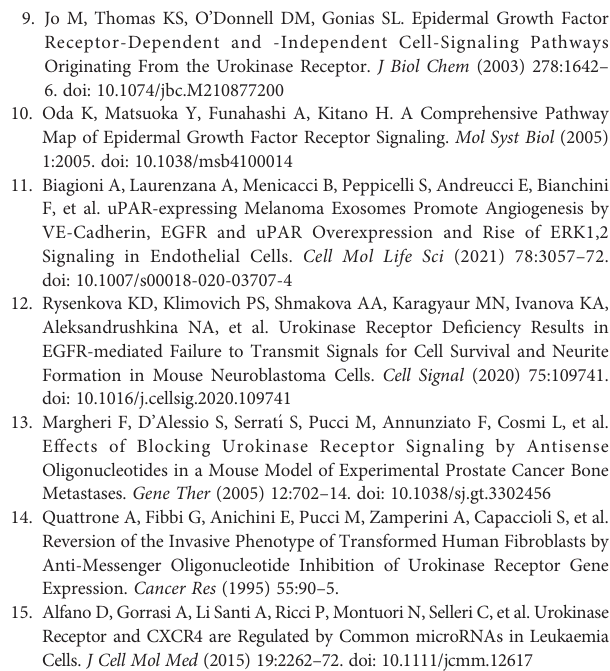
Supplementary Figure 1 | Annexin V/PI assay on control and uPAR KO cells. Values are mean ± SD; ns, not signi fi cant (n=3). (Student ’ s Test). Supplementary Figure 2 | Total RNA isolated was subjected to Reverse Transcriptase-PCR analysis of uPAR-3 ’ UTR expression, and b 2M was used as a loading control (n = 3). Supplementary Figure 3 | Cells were tested for EGFR expression by FACS analysis after anti-miR146a treatment for 24h (n=3). Values are mean ± SD; ***p < 0.0001 (Student ’ s Test). Supplementary Figure 4 | Cellular growth counting the total number of cells 24 and 48 h after the initiation of the culture. (n = 3). In all the three cell lines evaluated the +3 ’ UTR samples did not show any signi fi cant changes with respect to their KO counterparts, demonstrating that only the rescue of PLAUR expression is able to restore cell proliferation to control level. Supplementary Figure 5 | Whole Western Blot picture reporting uncropped